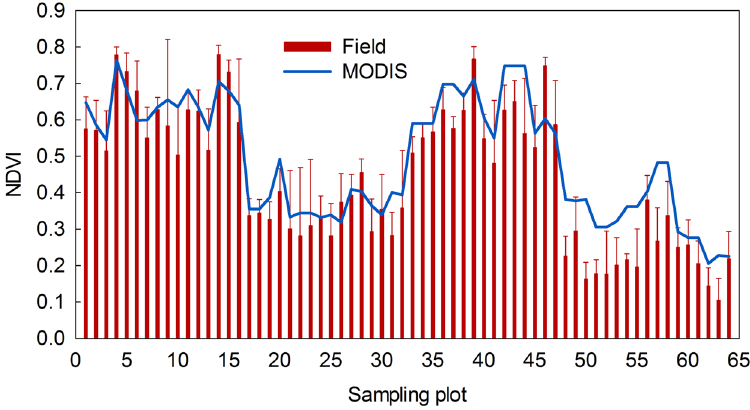
Figure 1. Comparison of NDVI calculated from MODIS and field-measured canopy reflectance